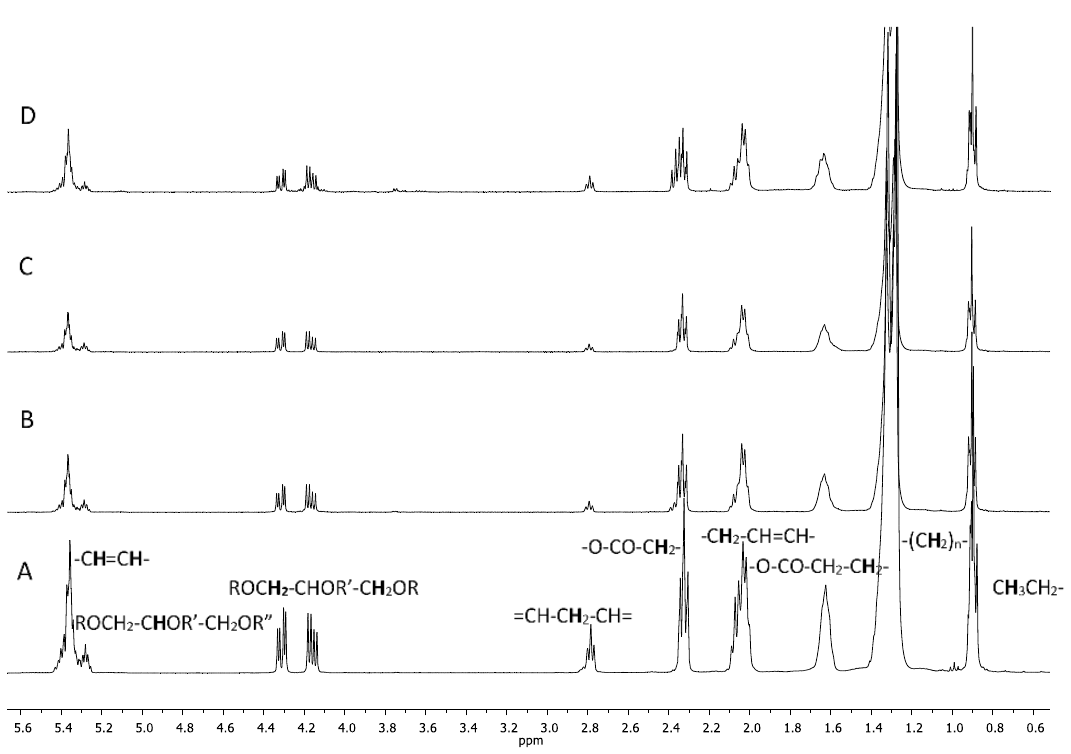
Figure 1. 1 H NMR spectra recorded at 400 MHz in CDCl 3 of extracts obtained from Ganoderma lucidum spores: ( A ) commercial liquid extract; ( B ) by n -hexane; ( C ) by n -hexane in Soxhlet apparatus; ( D ) by reflux in CHCl 3.